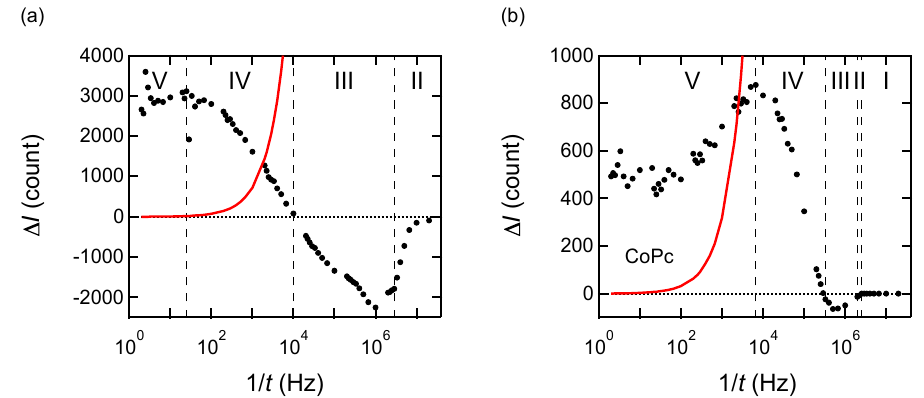
Figure 5. ∆ I versus the reciprocal of t , i.e., 2 f , for the ITO/TPD/Alq 3 /Al device ( a ) and ITO/CoPc/Alq 3 /Al device ( b ). The solid line is calculated by Equation (6) with the parameter sets used in Figure 3. To interpret the t dependence of ∆ I , we divided t into five regions, I, II, III, IV, and V.